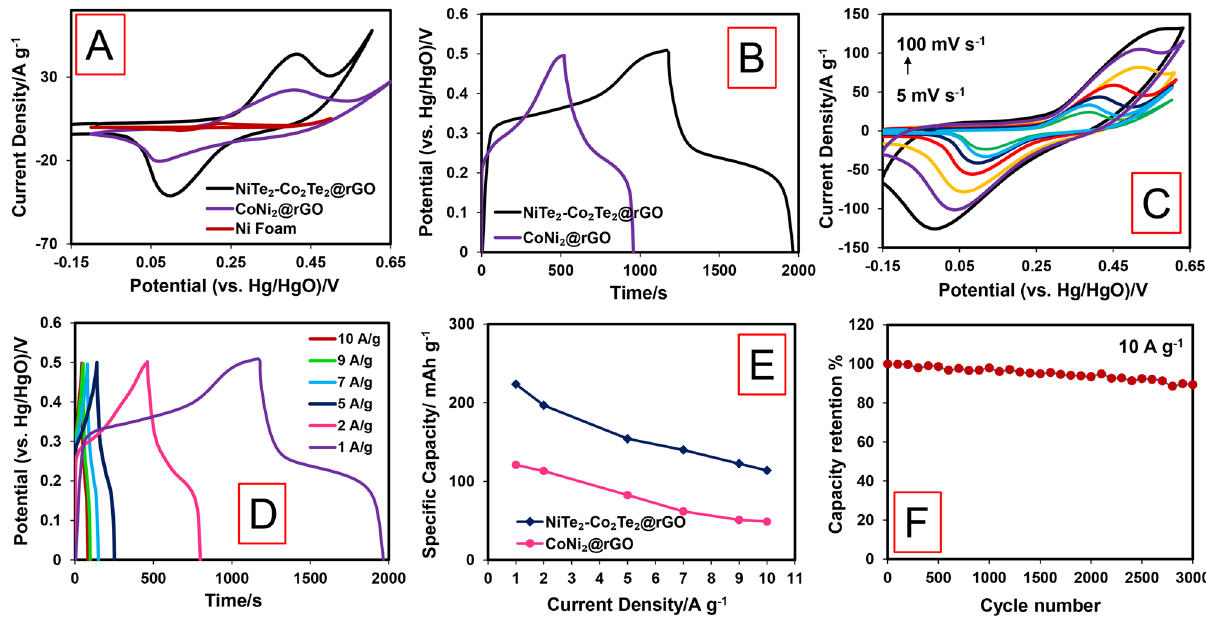
Figure 3. Electrochemical performance measurements in a three-electrode system; ( A ) CV curves of the NF,